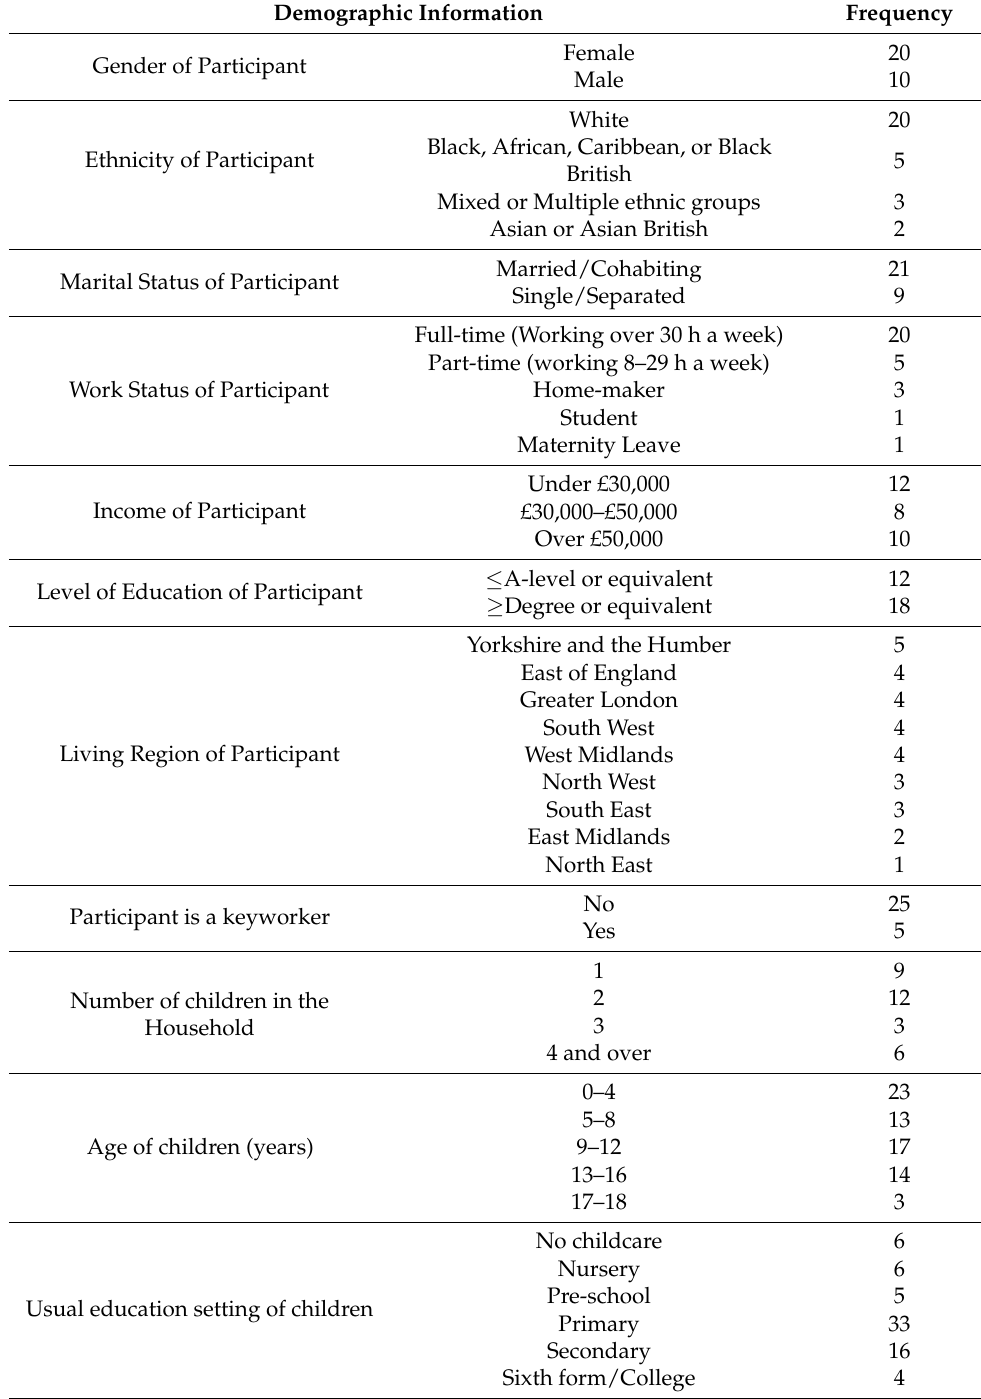
Table 2. Participant (n = 30) and children (n = 70) demographic